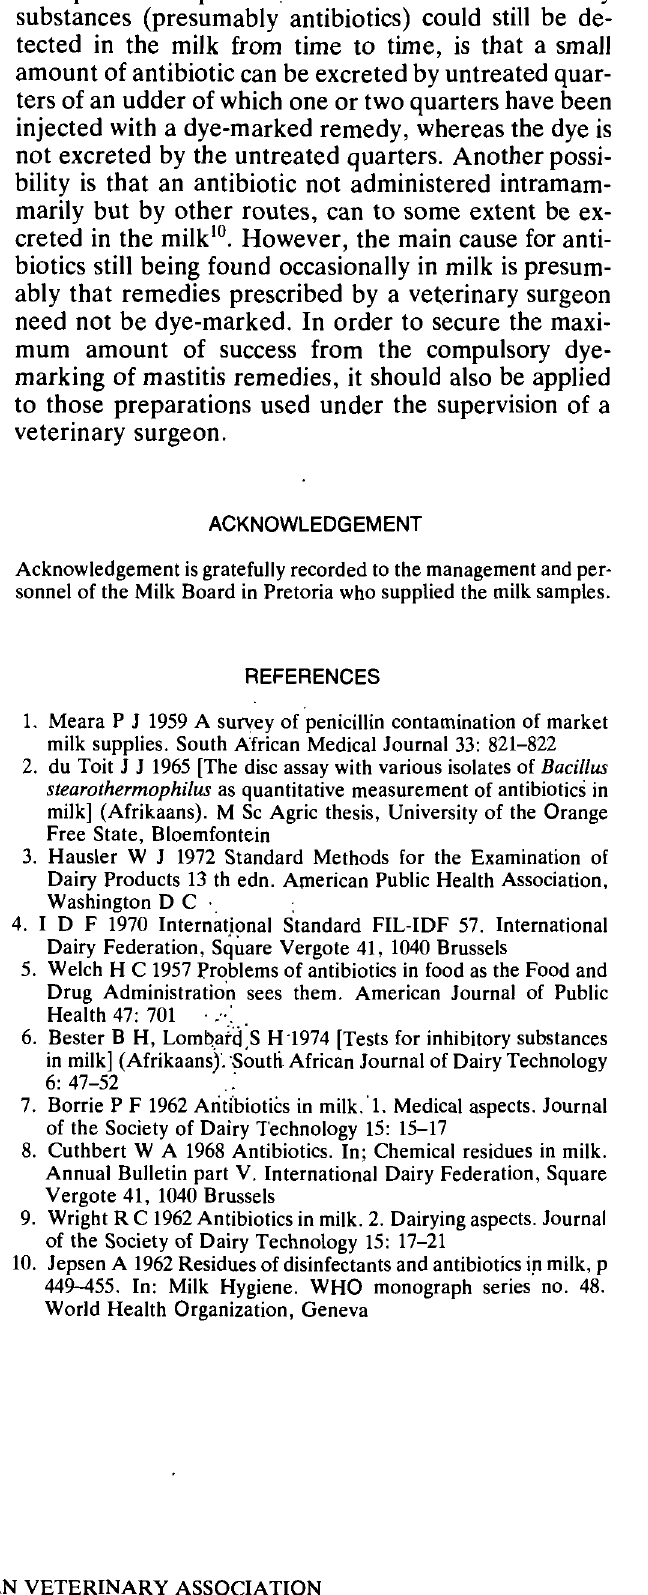
Tanker milk samples No. positive. % 3 5,0 1 1,67 1 1,67 1 1,67 1 1,67 0 0 0 0 0 0 7 11,7